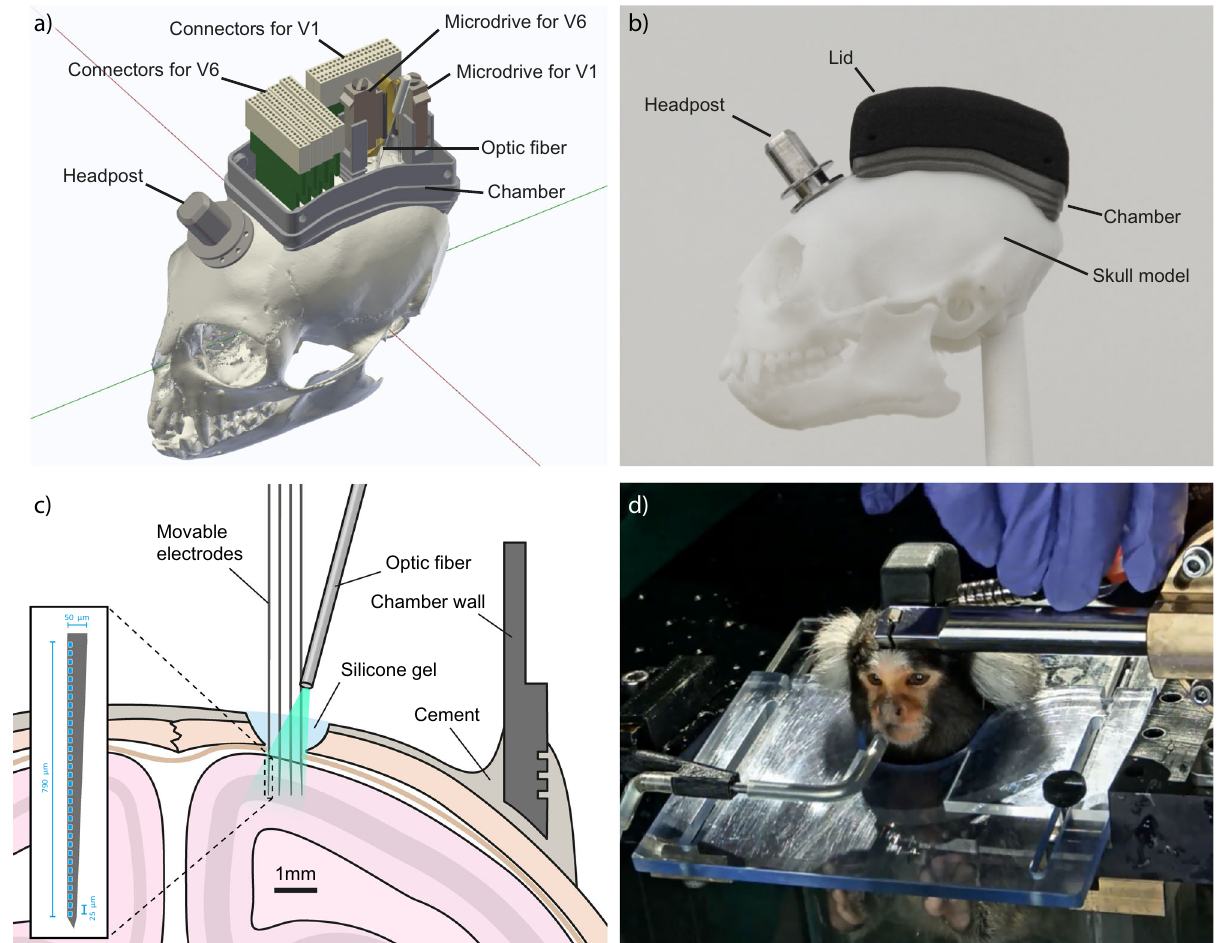
Fig. 1 | Implant design and recording approach. a 3D rendering of the complete 192-channel implant design. A four-shank silicon probe with 4×32 channels is attached tothemicrodrive targeting areaV6.Atwo-shanksilicon probewith 2×32 channels is targeting area V1. The four connectors at the anterior end of the chamber are wired to the probe in area V6. The two connectors at the posterior right side of the chamber are wired to the probe in V1. An optic fi ber (200 µ m diameter) is placed above the V6 craniotomy with an external micromanipulator that guarantees fl exible and precise positioning (not shown for clarity). The